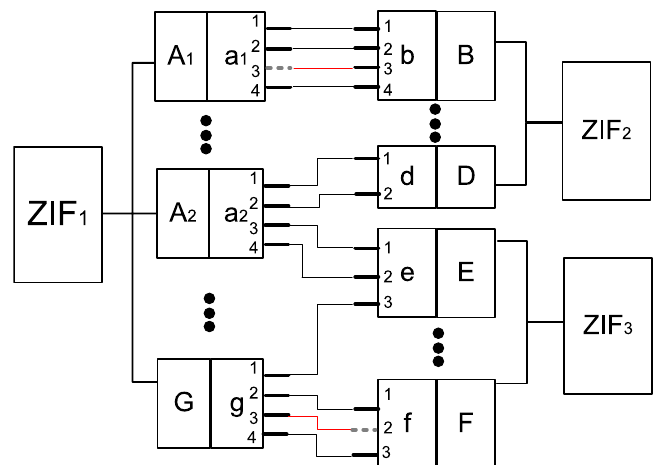
Fig. 11 Wrong connection in the aircraft wiring